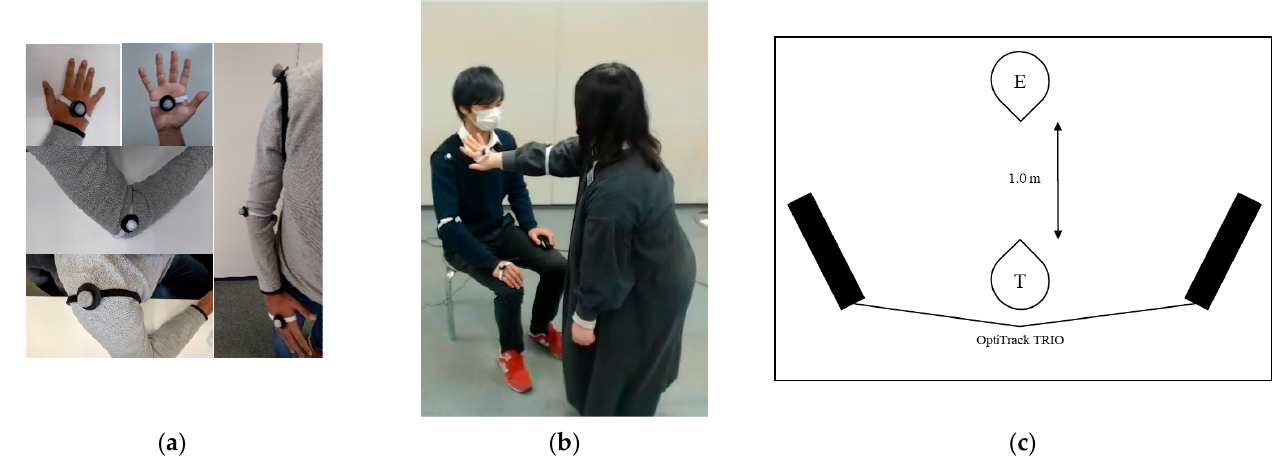
Figure 2. Data collection environment: ( a ) markers attached to both toucher and evaluator; ( b ) toucher is moving her hands toward evaluator’s body; ( c ) data collection setup using two OptiTrack systems for tracking both.